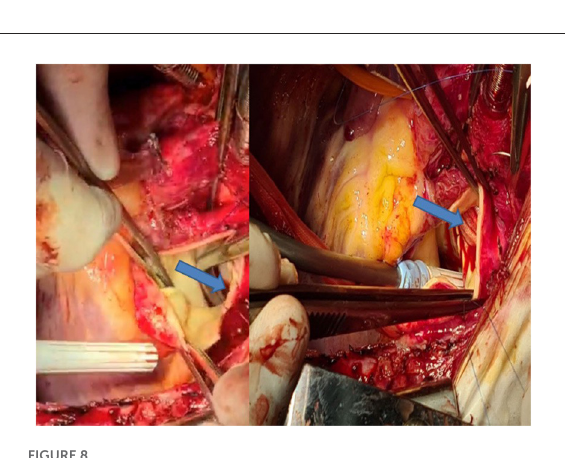
FIGURE8 Left: Intraoperative view through the pulmonary artery during circulatory arrest, showing the large communication with the descending aorta (blue arrow). Right: Closure with a vascular patch (blue